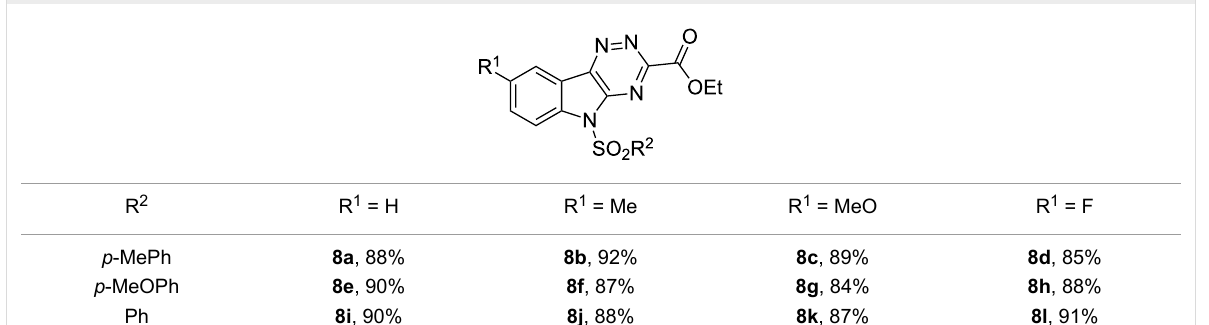
Table 1: Preparation of N-protected isatin-derived 1,2,4-triazines 8 . a